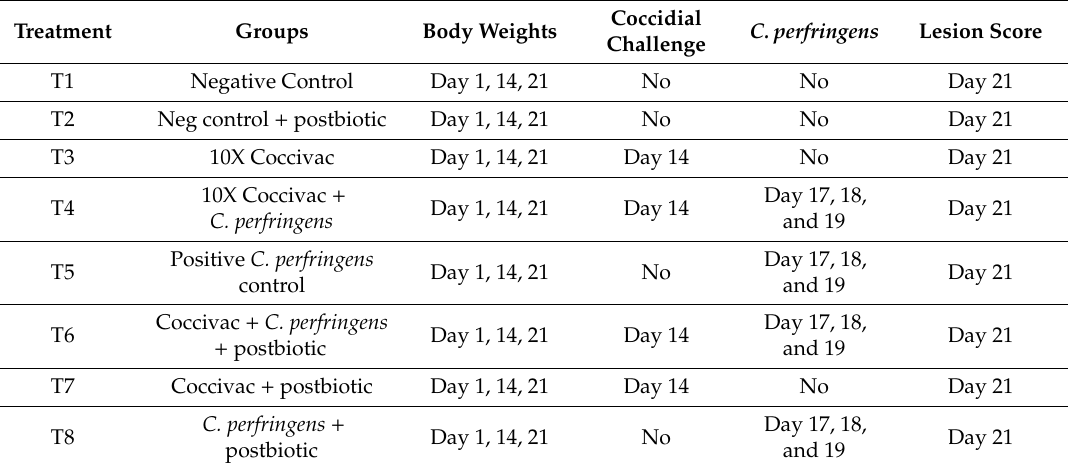
Table 1. Experimental Treatment